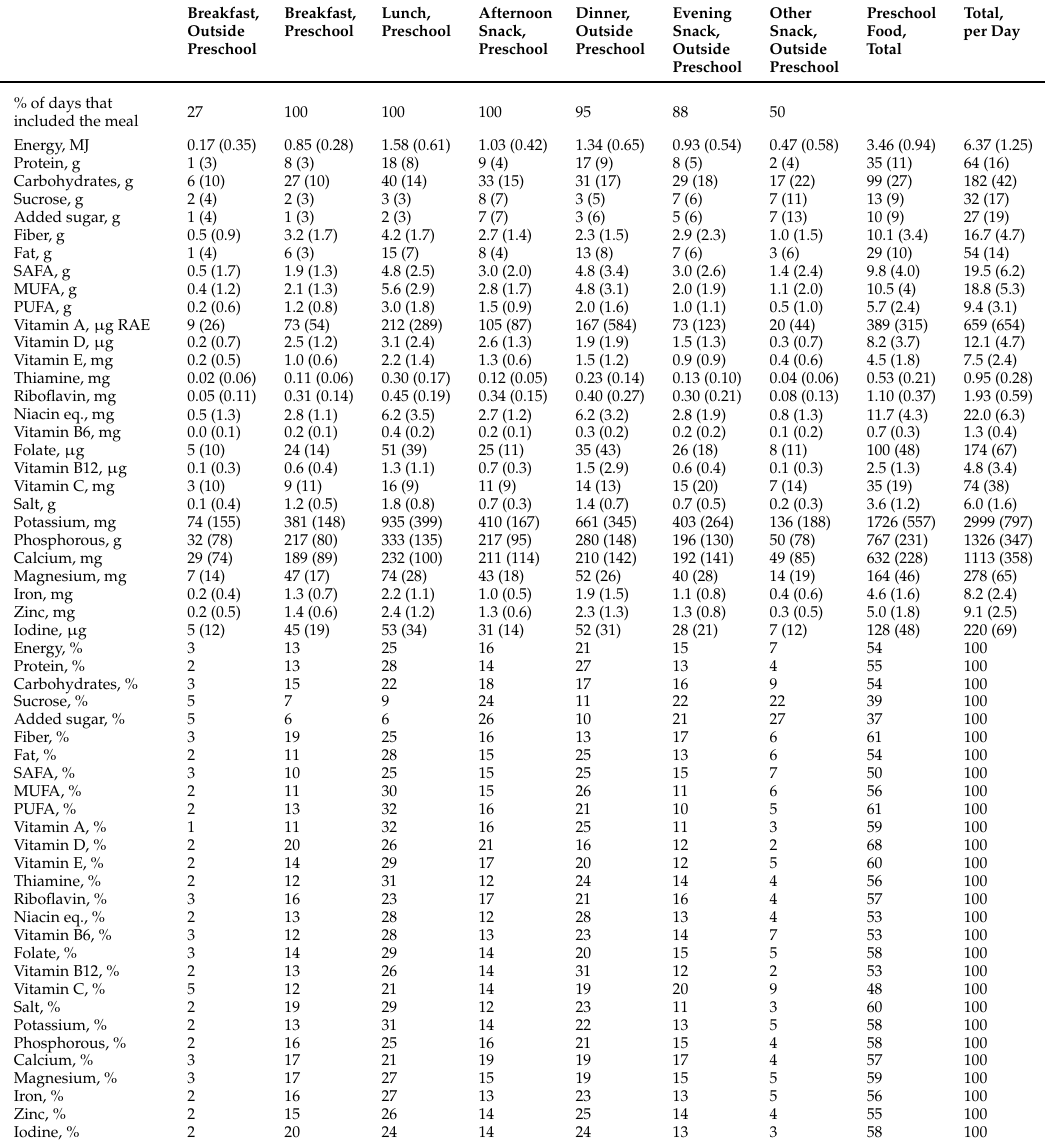
Table 5. Mean (SD) intake and population proportion [24] of energy and nutrients on weekdays among 5 to 6-year-old children who eat three meals at preschool ( n = 233). Each child had data for 1 to 4 days; the total number of days was